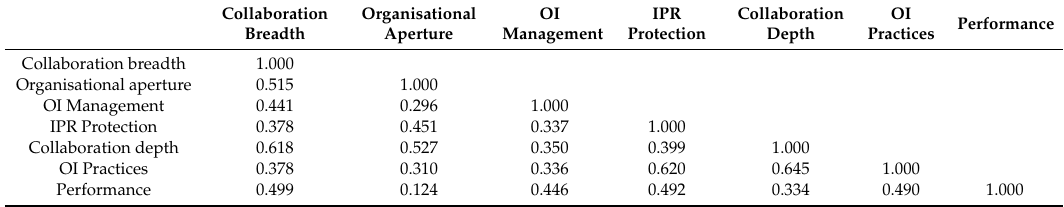
Table 11. Correlation among structural model variables.